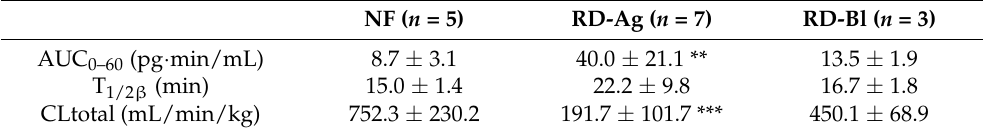
Table 1. Pharmacokinetic parameters for AM infusion in rats with or without renal